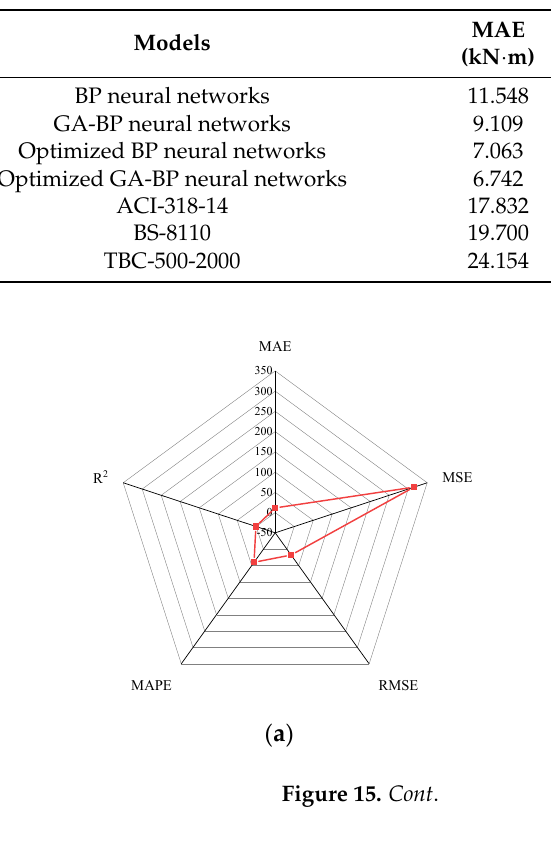
Figure 14. Prediction of torsional strength of TBC-500-2000. Table 5. Calculation results of different models.